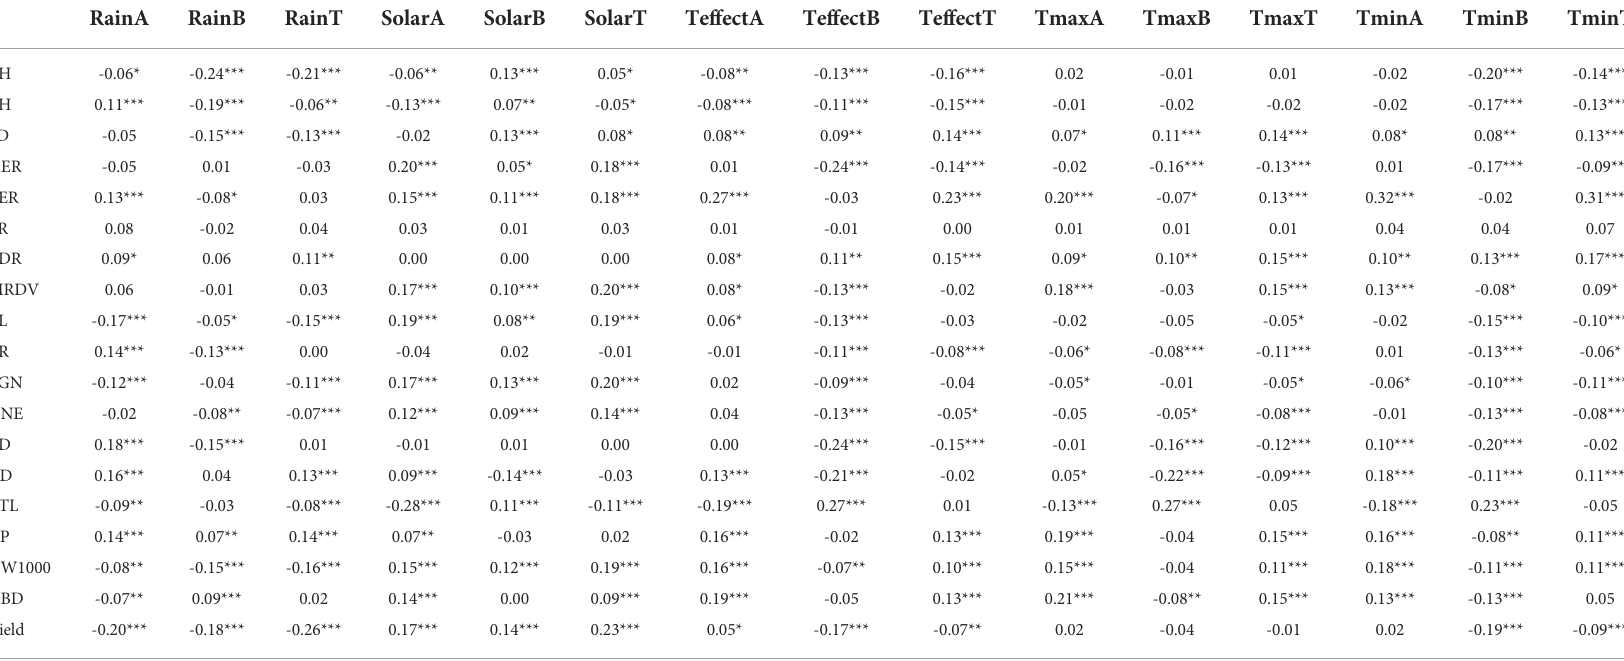
TABLE 4 Correlation analysis of plant agronomic traits, yield and meteorological